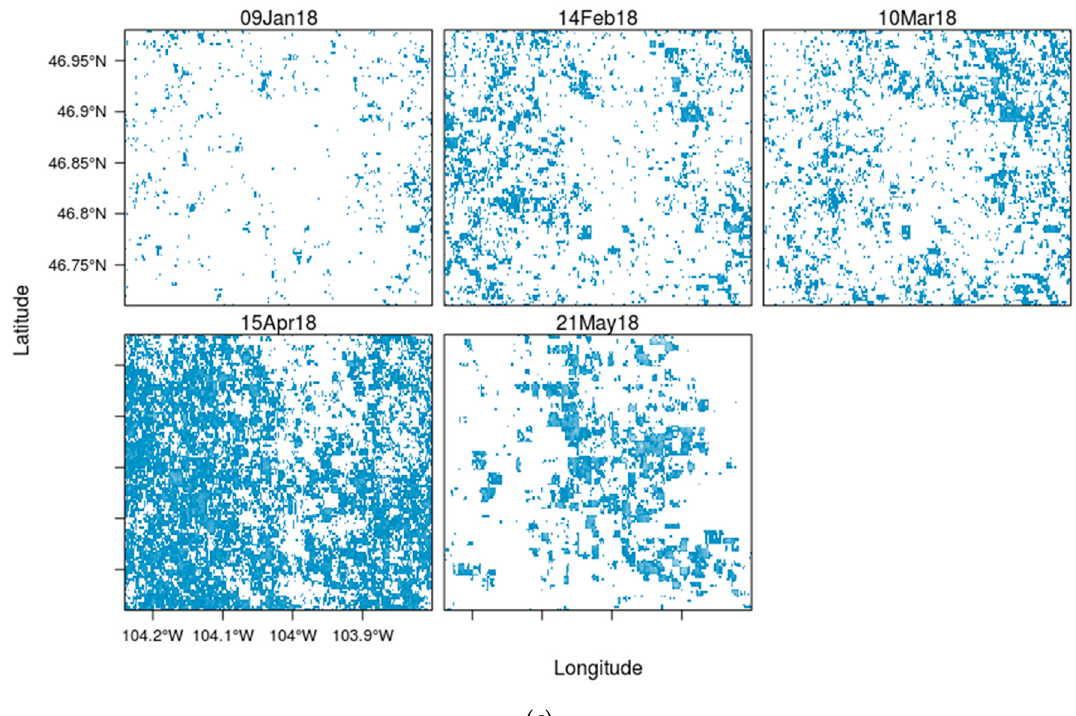
Figure 19. ( a ) Wet snow map of the Grand Mesa based on [26] modified to use VH BSC ratios instead of local incidence angle for classification. Pink color indicates wet snow. ( b ) Wet snow map (blue) at 250 m resolution using Sentinel-1 data for the Swiss Alps as per [26]. ( c ) Wet snow (blue) map of North Dakota as per [26].